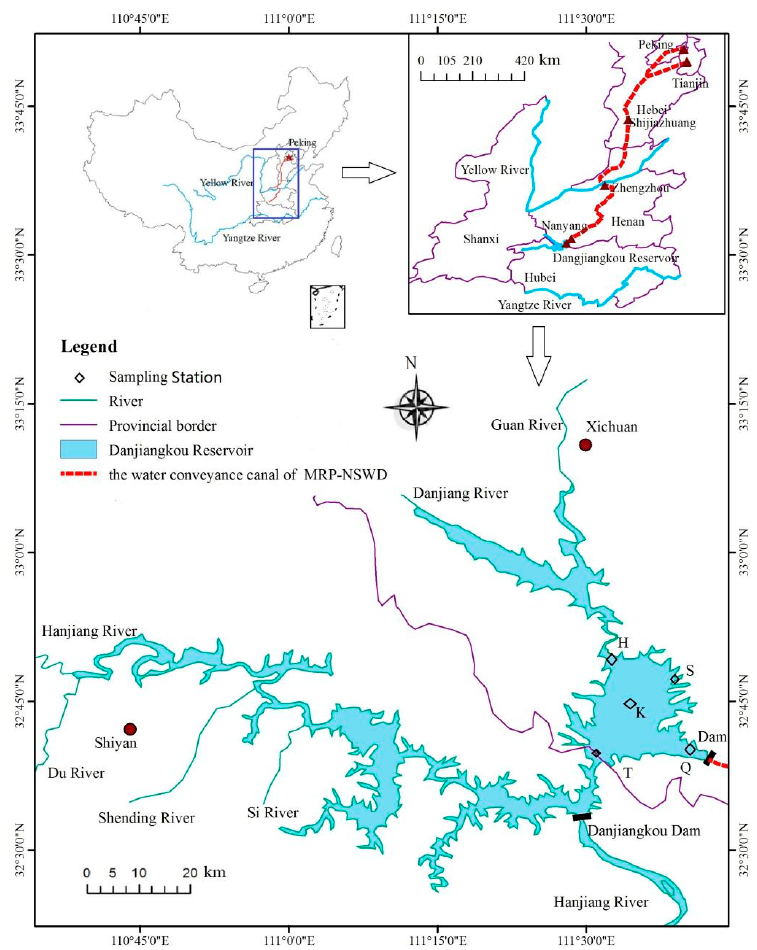
Figure 1. Locations of the five sampling stations in the Danjiangkou Reservoir and the water conveyance canal of the Middle Route Project of South-North Water Division in China. Station codes represent the first letter of their names: Q: Qushou, K: Kuxin, S: Songgan, H: Heijizuo, T: Taizishan. The reservoir is located in the north sub-tropic monsoon climate region with an annual mean temperature of 15~16 ◦ C and annual precipitation 800~1000 mm, of which 80% is concentrated in the period from May to October. The monthly maximum precipitation is 193.7 mm and the minimum is 31.0 mm. Soil types include alluvial soil, lime concretion black soil, yellow brown loam and purple soil. The watershed around the reservoir is dominated by mountainous areas (85%) and forest coverage (76%)